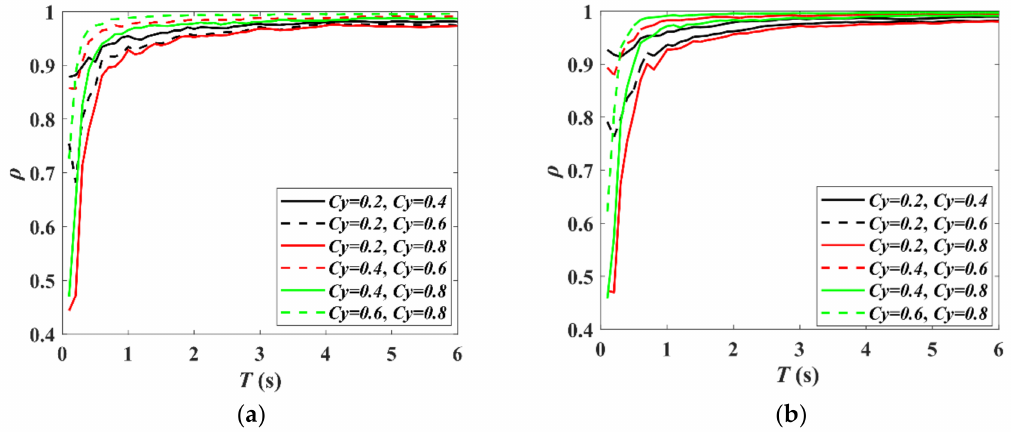
Figure 5. Correlation analysis of S d rankings under different C y conditions. ( a ) Bilinear model, ( b ) modified Clough